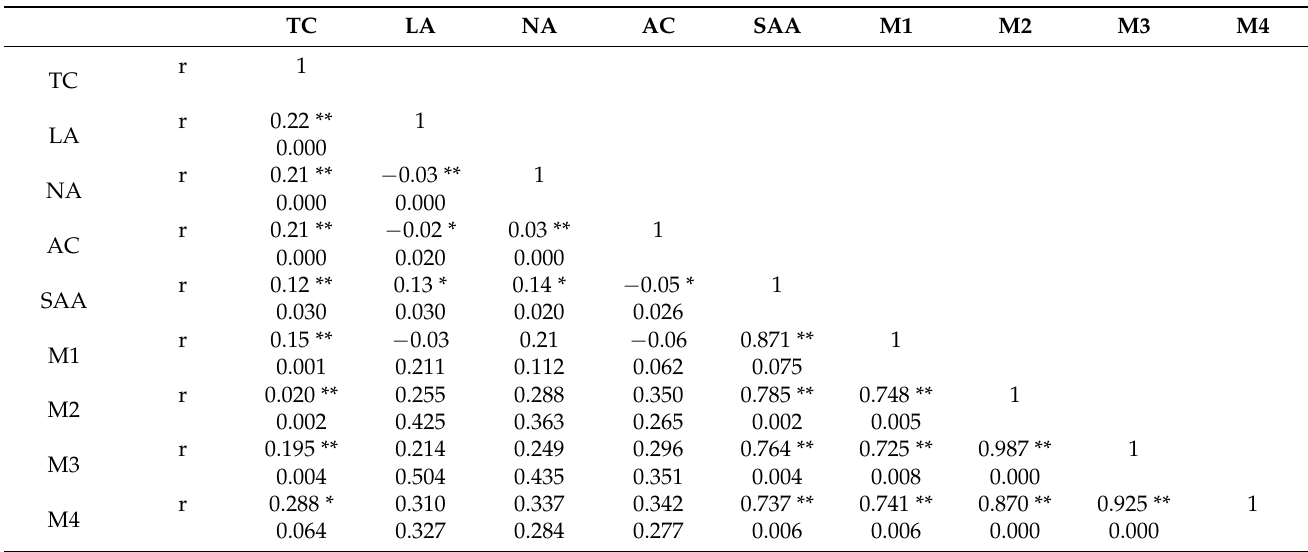
Table 9. Correlation matrix of